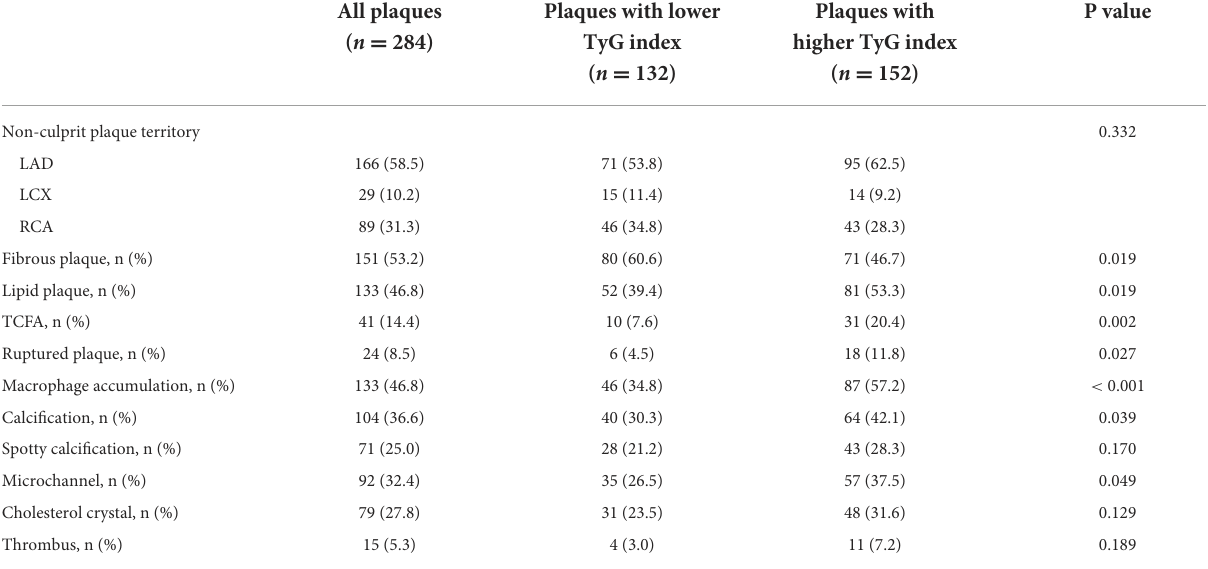
TABLE 3 Plaque-level angiographic and OCT analysis of non-culprit plaques comparing lower vs. higher TyG index.